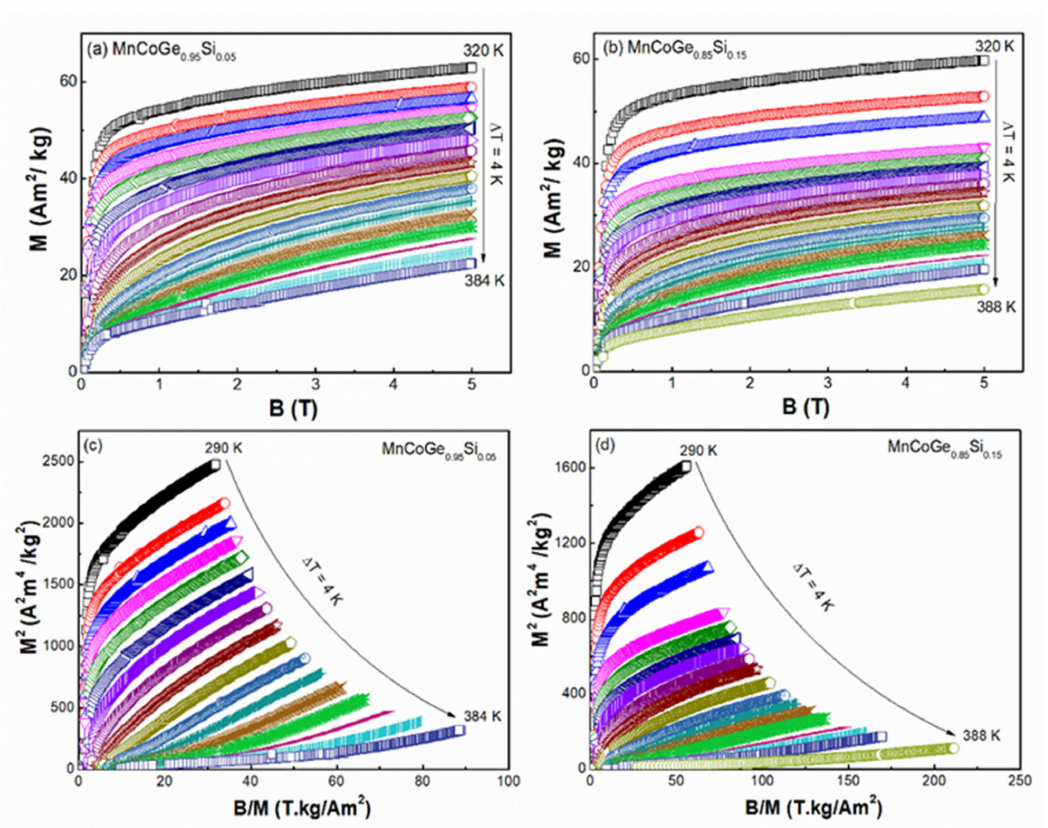
Figure 3. Magnetization curves with an applied field of 0–5 T for the compounds of ( a ) MnCoGe 0.95 Si 0.05 and ( b ) MnCoGe 0.85 Si 0.15 . The second-order transition Arrott plot types for both compounds are shown in ( c , d